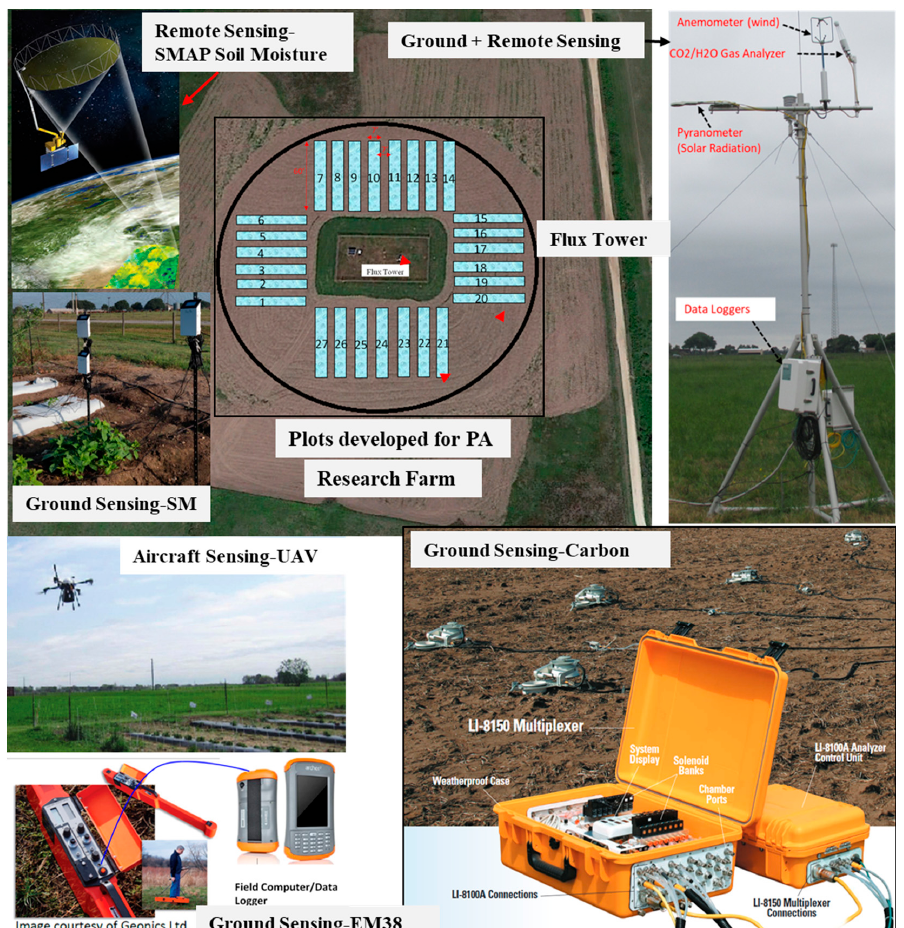
Figure 1. A typical layout for the remote, aircraft, and ground sensing systems deployed for precision agriculture. SMAP = Soil Moisture Active Passive; PA = Precision Agriculture; SM = Soil Moisture; UAV = Unmanned Aerial Vehicle; EM = Electromagnetic. (UAV photo credit – Dr. Ripendra Awal, PVAMU, Prairie View, TX, USA).